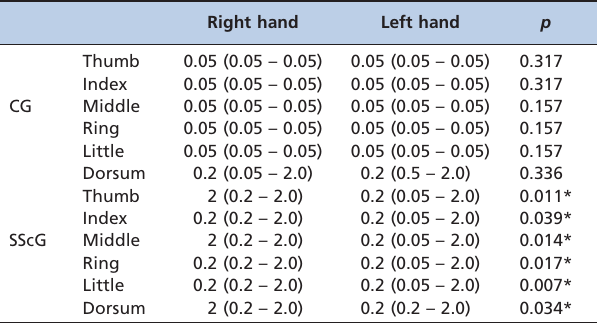
Table 4 - Intra-group comparison of the monofilament